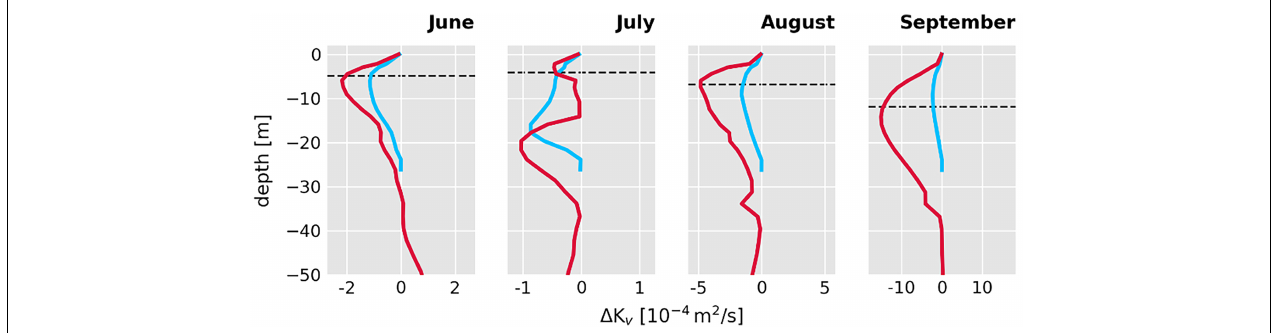
FIGURE 10 | Monthly mean profiles in mixing rate for the period of June to September. The dashed lines indicate the location of the mixed layer depth. For the profiles, grid points within 5 km around each wind farm were considered. Profiles are divided into deep ( z ≥ 25 m, red lines) and shallow ( z < 25 m, blue lines) water